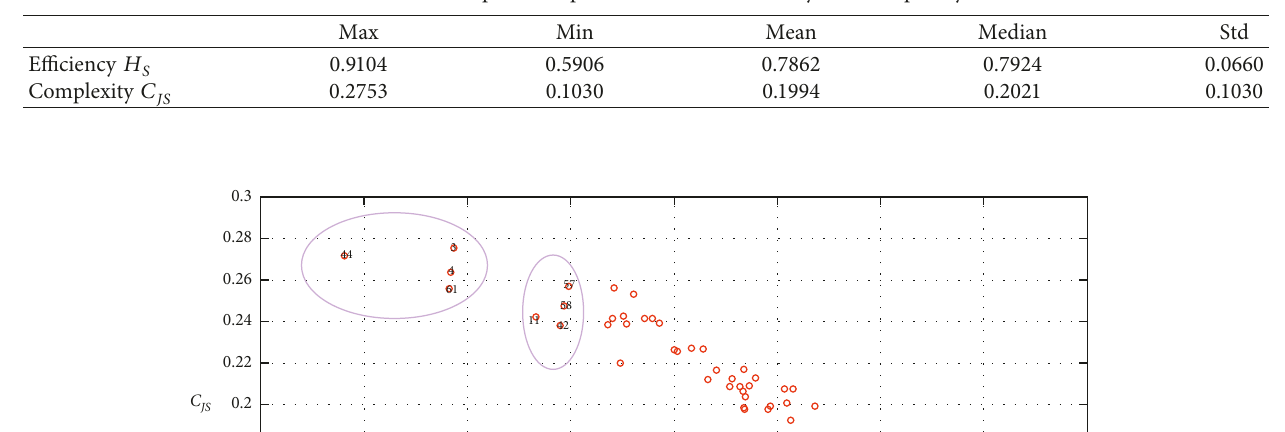
Figure 5: The selection of embedding dimension. Table 2: The simple descriptive statistics of efficiency and complexity.